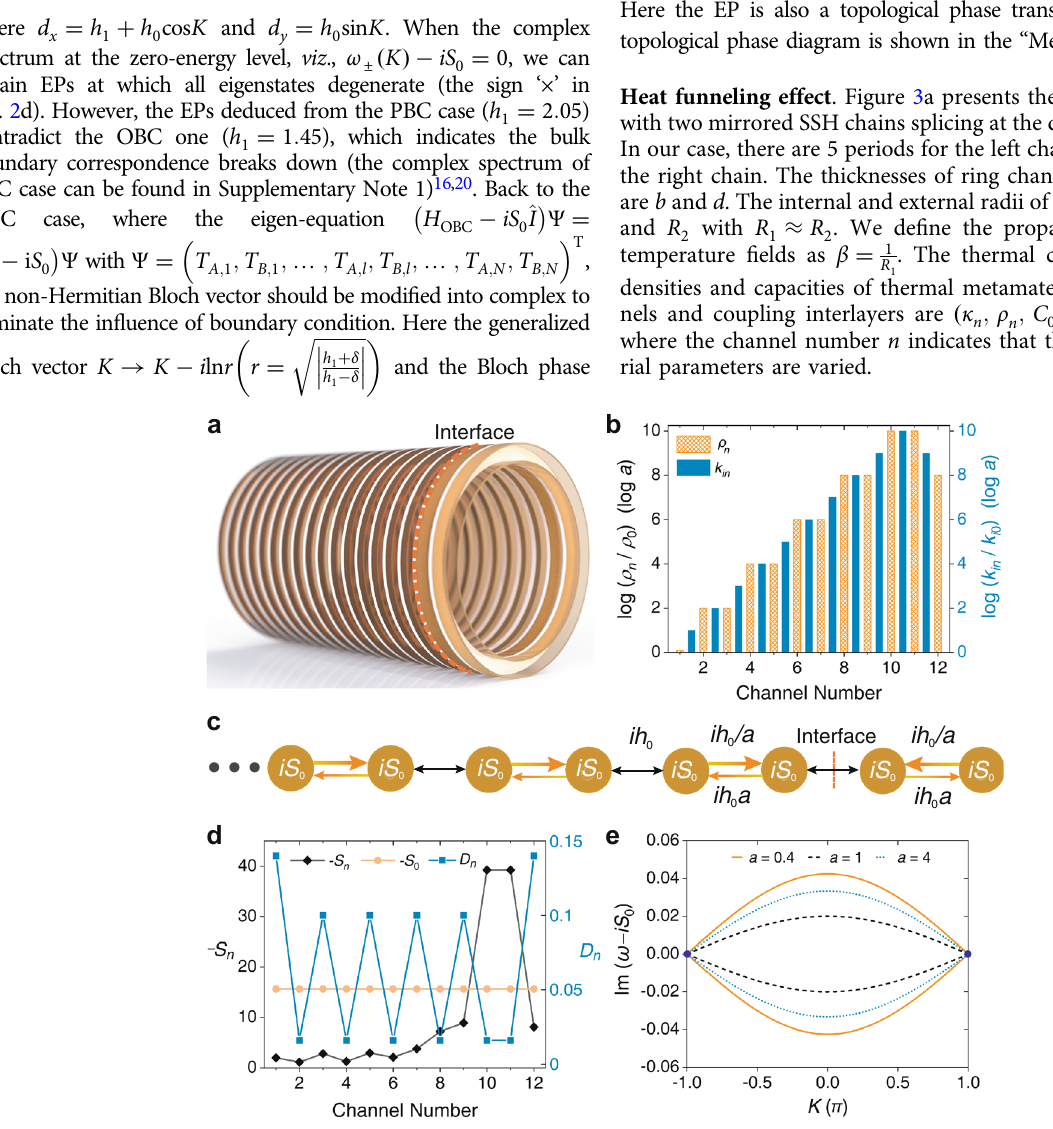
Fig. 3 Heat funneling model. a Schematic of the coupled ring structure for realization, where the red dashed line denotes the position of interface, there are 5 periods for the left chain and 1 period for the right chain. b Thermal conductivity ( κ i ) and mass density ( ρ n ) distributions of thermal metamaterials for the ring channels and coupling interlayers. c Equivalent tight-binding model, with the asymmetric intracell couplings are ih 0 a and ih 0 a . d Homogenization of the decay rates of channels iS n at a ¼ 0 : 4, D n are the diffusivity of channels. e Generalized gapless Bloch bands of the non-Hermitian Su-Schrieffer-Heeger (SSH) model at a ¼ 0 : 4 ; 1 ; 4, K is Bloch vector and ω is the